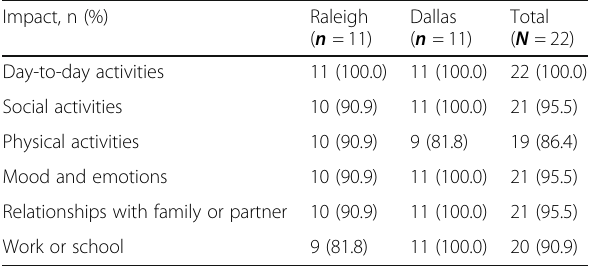
Table 3 Frequency (%) of Endometriosis-Related